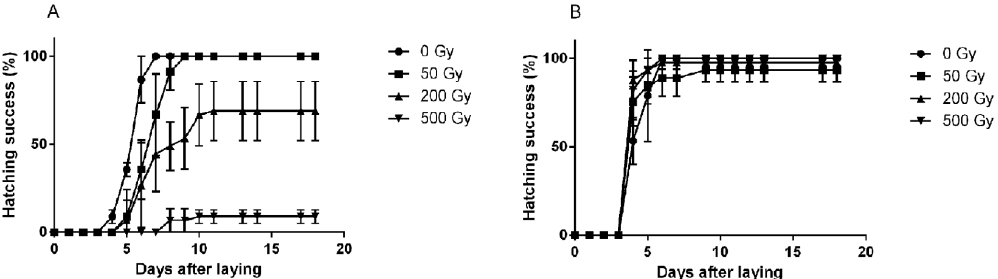
Figure 3. Patterns of hatching success of Hypsibius exemplaris eggs irradiated in the hydrated state with different doses of γ -ray and at two different stages of egg development; ( A ) early developmental stage and ( B ) late developmental stage. The error bars represent standard deviations from three repeats, each with 15 eggs. Reprinted from Beltrán-Pardo et al. [28] (Figure 3) under a Creative Commons Attribution-NonCommercial-ShareAlike 4.0 International License.